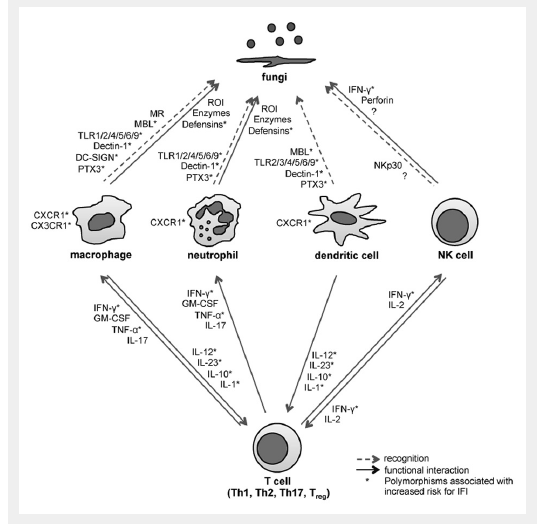
Single nucleotide polymorphisms pathways of innate and adaptive antifungal immunity associated with increased risk for invasive fungal infections. NK cell = natural killer cell; MR = mannose receptor; MBL = mannose-binding lectin; TLR = Toll-like receptor; PTX3 = pentraxin 3; ROI = reactive oxygen intermediates; IFN = interferon; GM-CSF = granulocyte macrophage colony stimulating factor; TNF = tumour necrosis factor; IL = interleukin ; IFI = invasive fungal